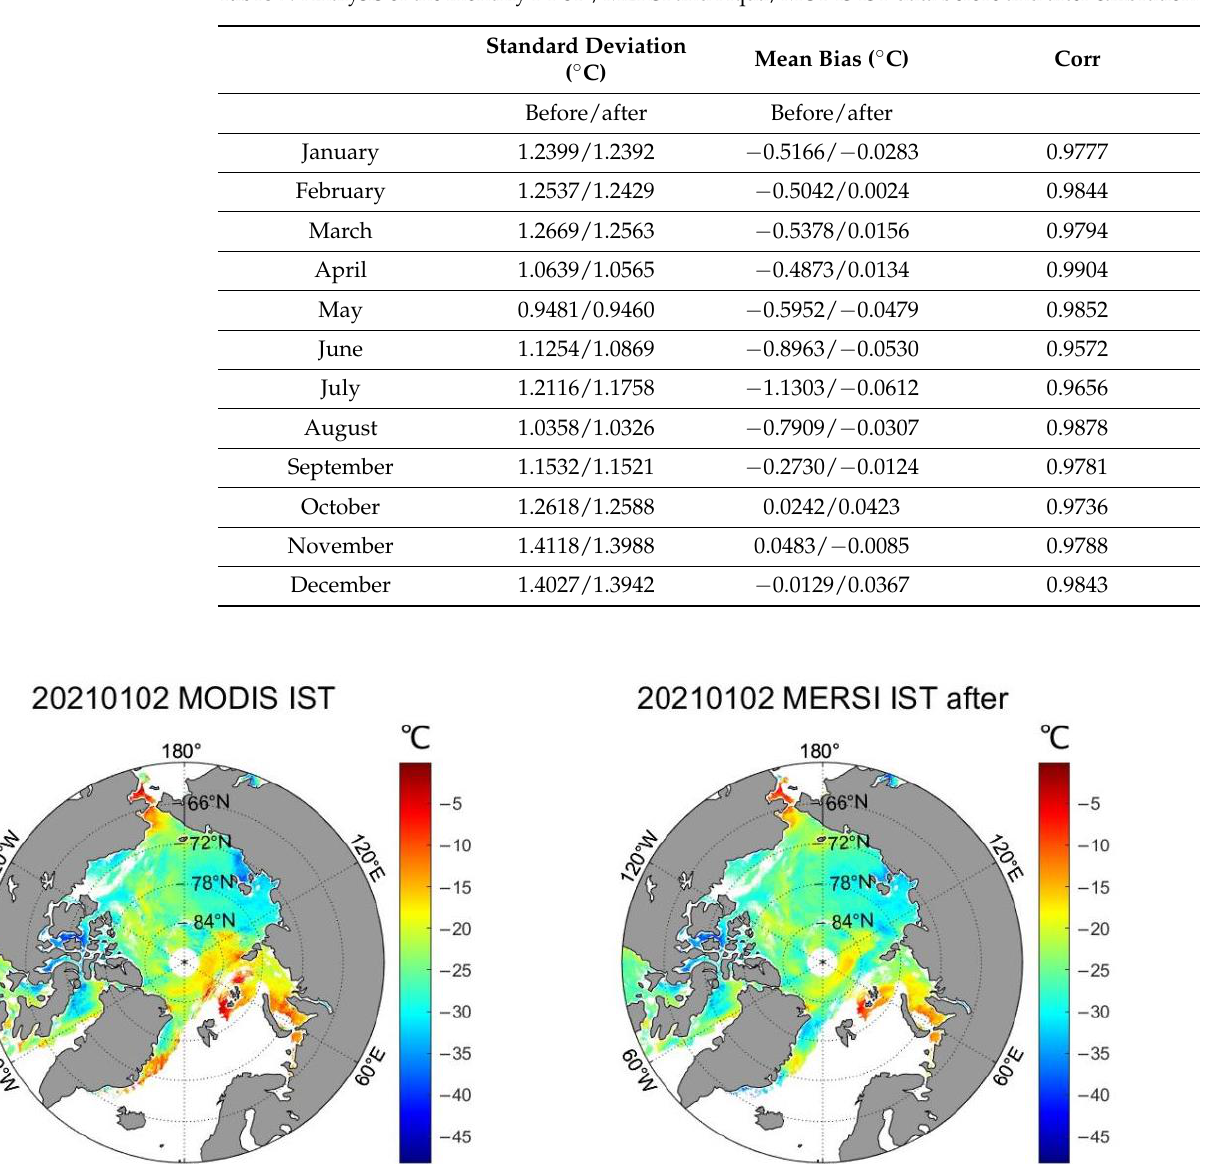
Table 7. Analysis of the monthly FY-3D/MERSI and Aqua/MODIS IST data before and after calibration.